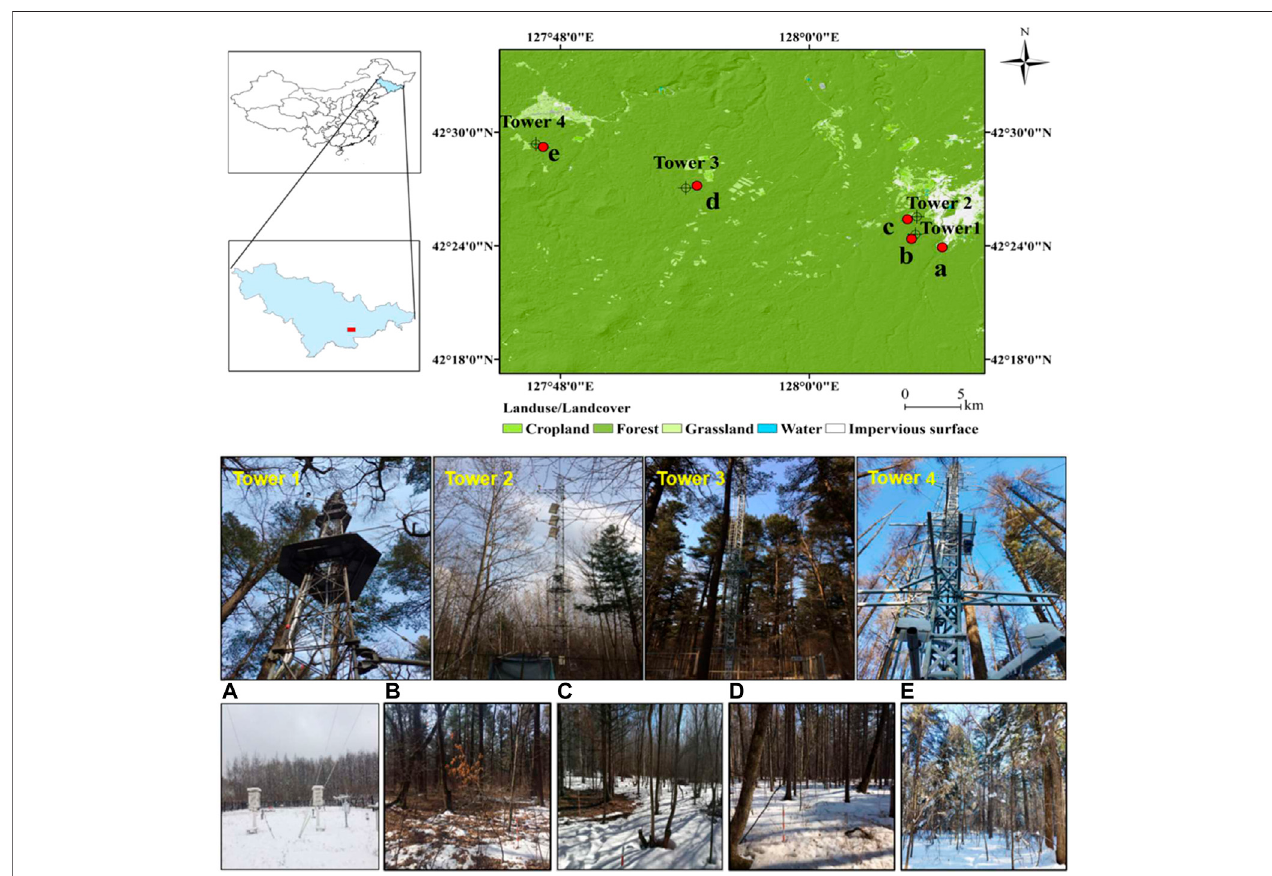
FIGURE1 | The location of thestudyarea (top row), pictures ofthe open-patheddy covariance (EC) fl ux system (middle row), and pictures ofthe plots in the study area in the Changbai Mountains, northeastern China (bottom row). The EC fl ux system corresponds to the plots one by one: Tower 1-b, Tower 2-c, Tower 3-d, and Tower 4-e. The letters in top and bottom rows correspond to different land types and disturbance intensities: (A) the open site (OS); (B) the natural mixed forest (NMF); (C) the high-intensity cutting mixed forest (HCF); (D) the moderate-intensity cutting mixed forest (MCF); and (E) the low-intensity cutting mixed forest (LCF).